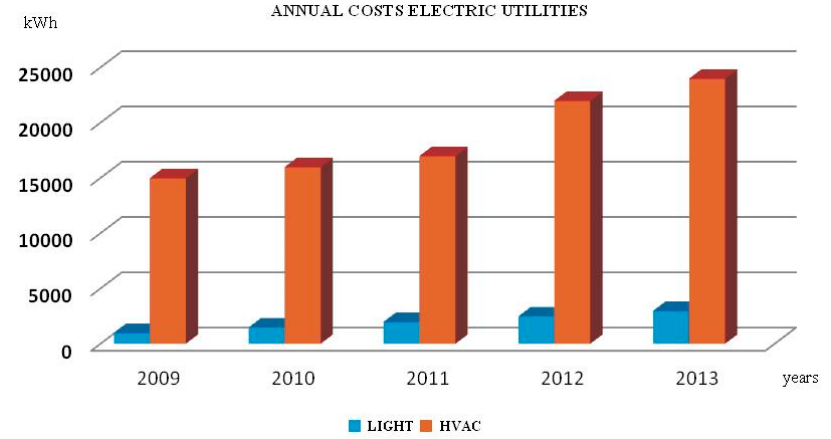
Figure 4. Annual consumptions for electric utilities (light and heating, ventilating and air conditioning (HVAC)) uses.